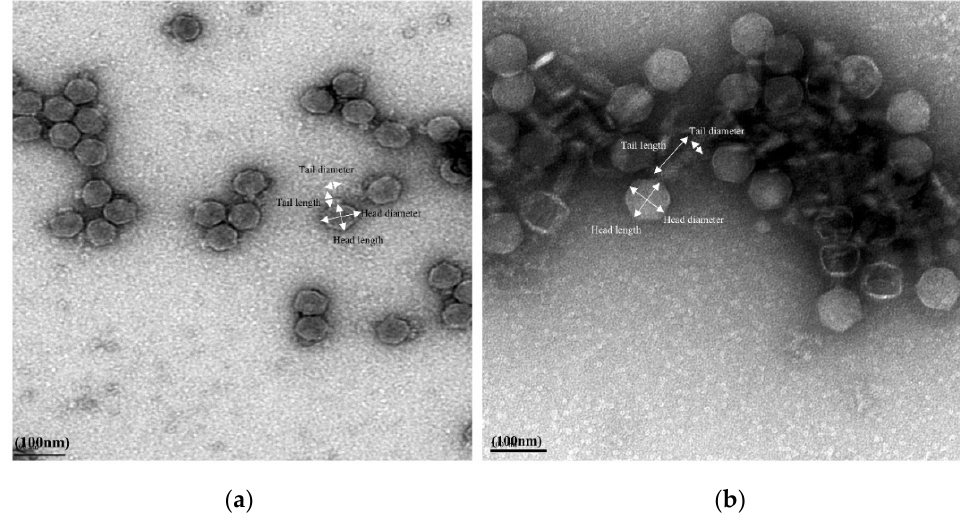
Figure 1. Transmission electron microscopy image of phage morphology ( a ) Ro103C3lw with a capsid (61.1 ± 0.5 nm in diameter and 58.8 ± 0.5 nm in length) and a short tail (17.0 ± 0.5 nm in length and 23.5 ± 0.5 nm in diameter), showing Podoviridae morphology. ( b ) Pr103Blw with a capsid (75.0 ± 0.5 nm in diameter and 73.6 ± 0.5 nm in length) and a long contractile tail (118.8 ± 0.5 nm in length and 21.0 ± 0.5 nm in diameter), showing Myoviridae morphology.